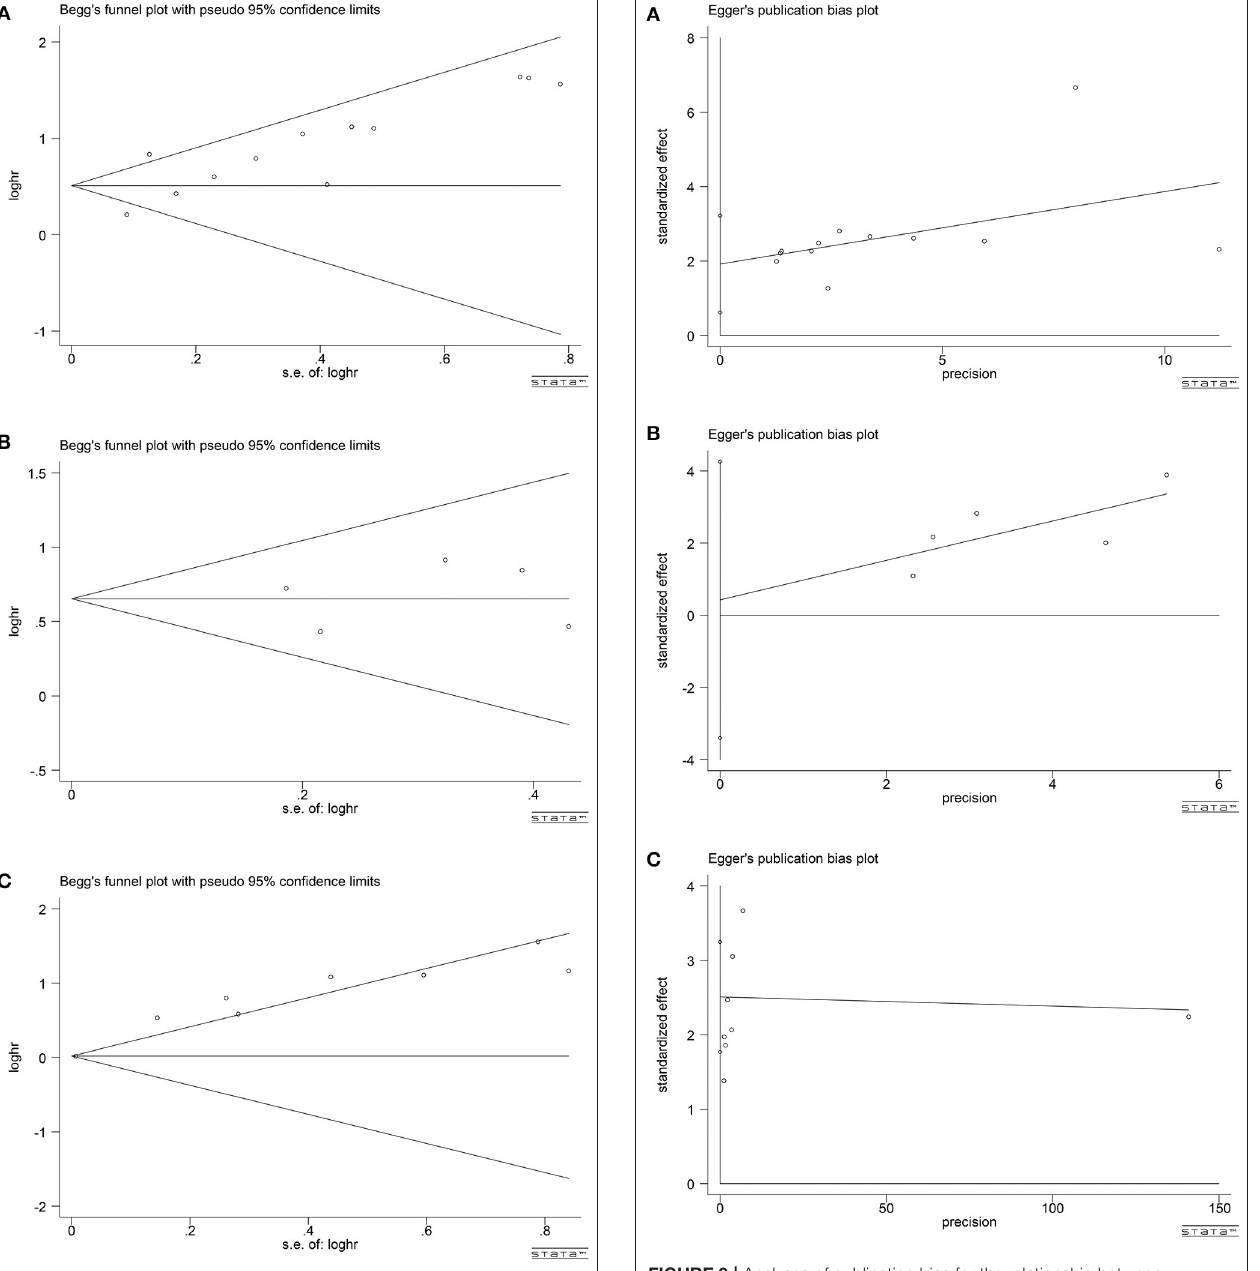
FIGURE 9 | Analyses of publication bias for the relationship between NLR/CRP/PLR and OS (A) Egger’s publication bias plot for NLR. (B) Egger’s publication bias plot for CRP. (C) Egger’s publication bias plot for